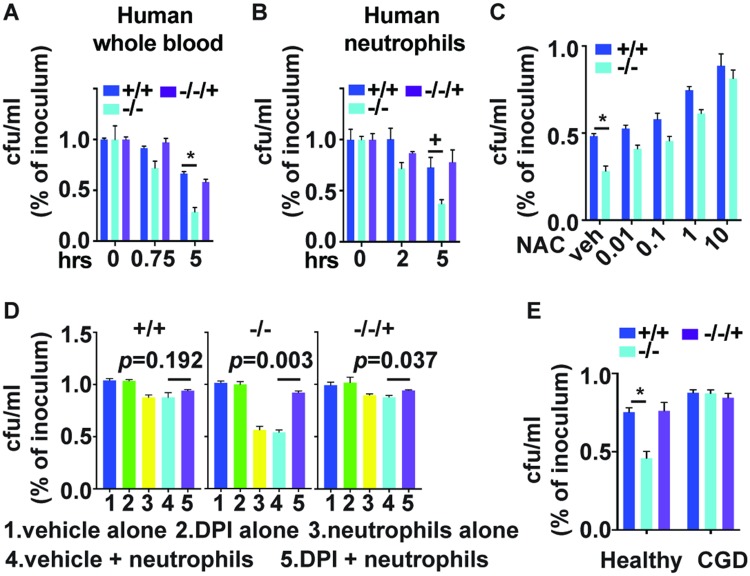
Pho84 is required for resistance to killing by whole blood or neutrophils, in dependence on neutrophil ROS.(A) Percent survival of C. albicans cells after incubation with whole blood from healthy human volunteers; cells of genotypes +/+, JKC915; -/-, JKC1450 and -/-/+, JKC1588 were inoculated into blood and plated onto agar medium at the indicated time points for calculation of CFU/ml. -/- versus +/+ at 5 h p = 0.008. (B) Percent survival of C. albicans cells after incubation with neutrophils, strains as in A, at M.O.I. 2 for 2 hrs and 5 hrs. -/- versus +/+ at 5 h p = 0.04. (C) Human peripheral blood-derived neutrophils pretreated with different concentrations of N-acetyl-l-cysteine (NAC) were incubated for 90 min with strains as in A at M.O.I. 2. -/- versus +/+ with vehicle p<0.0001. (D) Human peripheral blood-derived neutrophils pretreated with 10 μM Diphenyleneiodonium (DPI) were incubated for 90 min with strains as in A at M.O.I. 2. Vehicle alone, DPI alone and neutrophil alone groups are controls. (E) Chronic Granulomatous Disease patient-derived neutrophils (CGD) were incubated for 2 hours with strains as in A at M.O.I. 2. p<0.0001 for -/- in healthy control neutrophils (control) versus +/+ in control, all others non-significant. p values per Student’s t-test. *p<0.01; +p<0.05; ns is non-significant. A-D representative of at least 3 biological replicates.